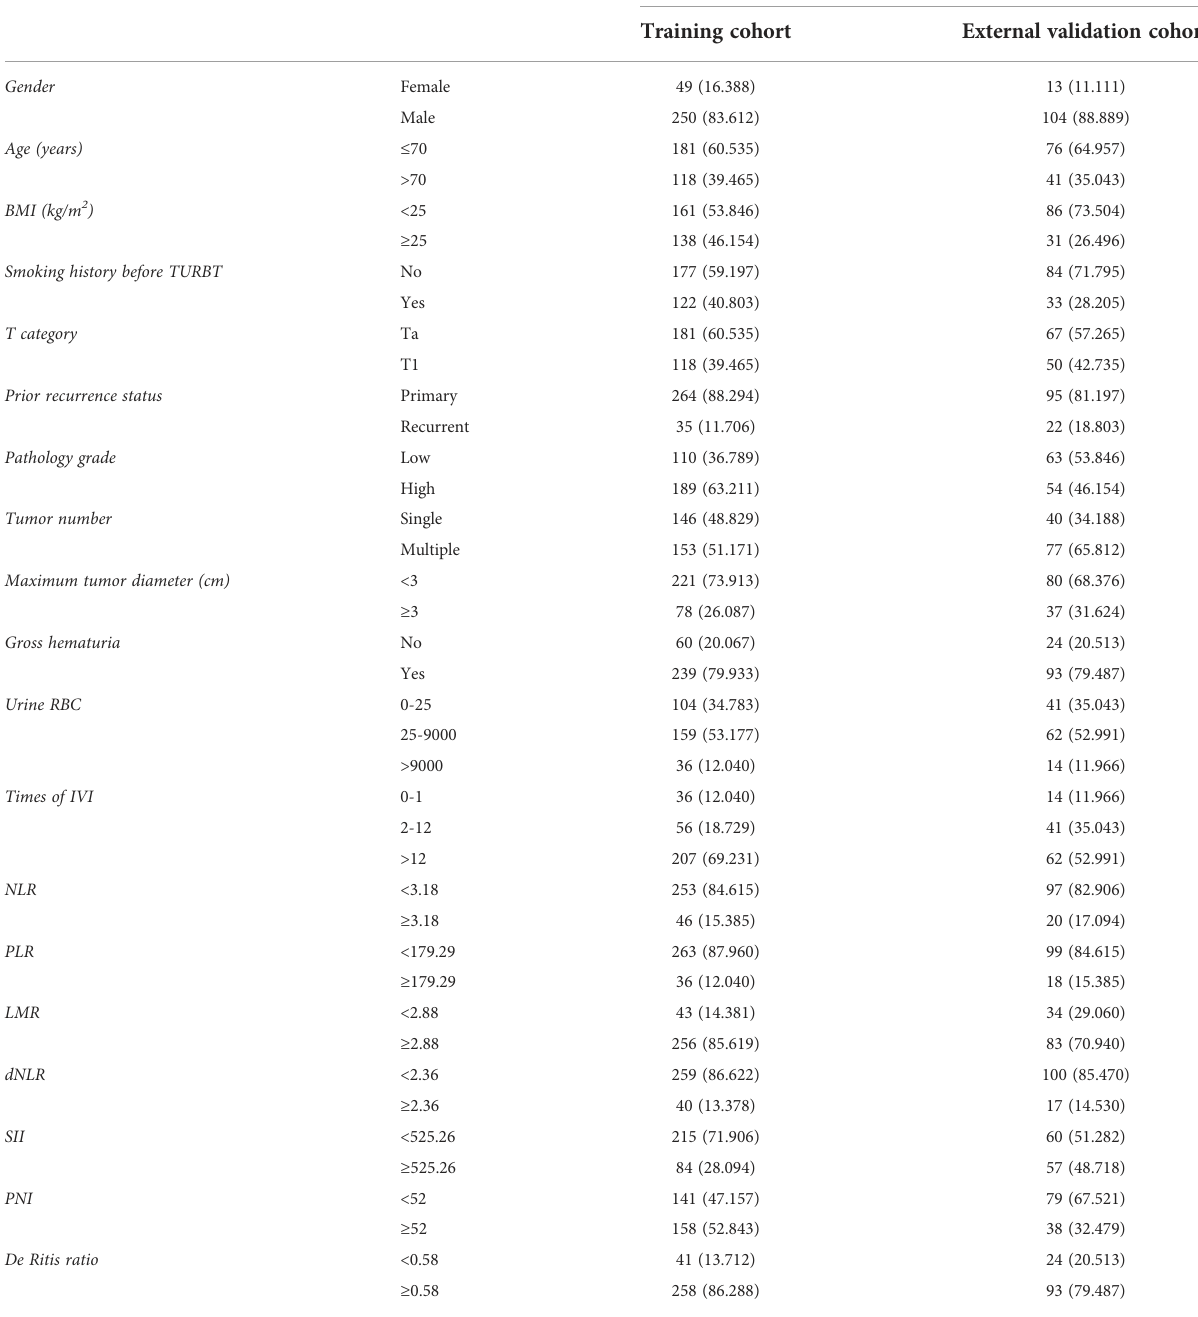
TABLE 1 Baseline demographics & clinical characteristics of the study